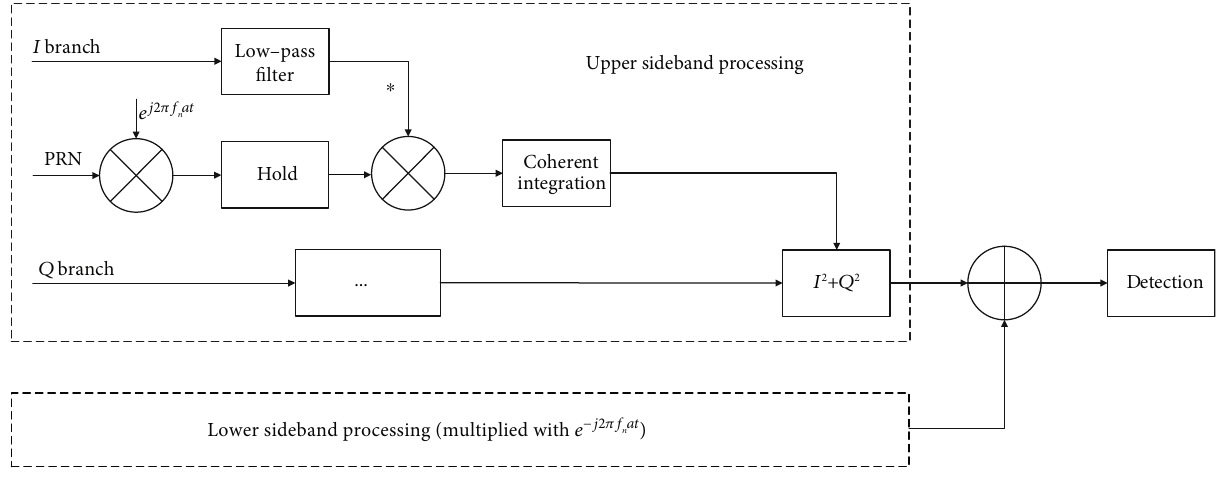
Figure 1: Flow chart of the Martin